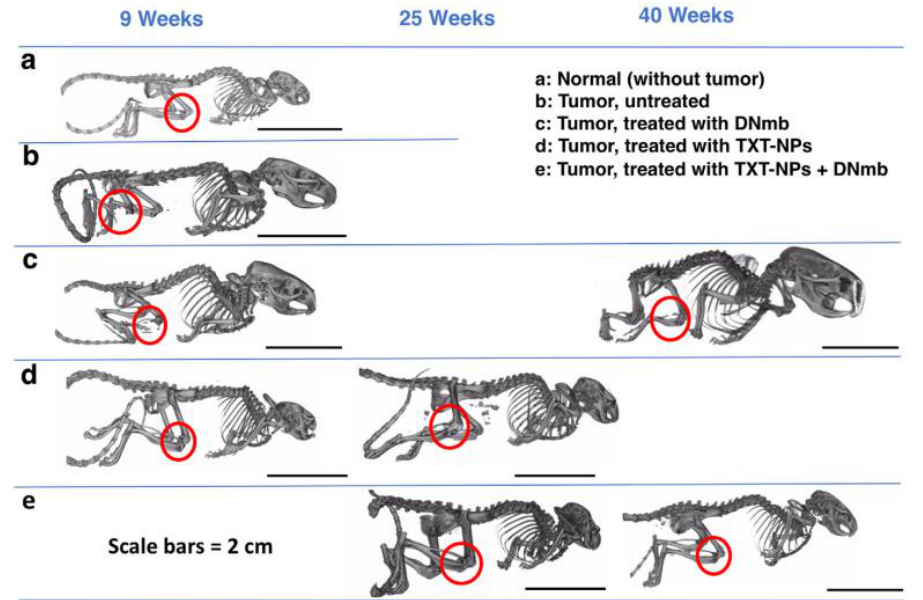
Figure 2. Micro-CT analysis for bone loss. Representative animals from different treatment groups underwent microCT at 9, 25, and 40 weeks. Group a : Normal (without tumor), b : Tumor, untreated, c : Tumor, treated with DNmb, d : Tumor, treated with TXT-NPs, e : Tumor, treated with TXT-NPs & DNmb. The combination treatment inhibited bone resorption most effectively. Histochemical analyses of the bone of the combination-treated animal demonstrated normal bone morphology, alkaline phosphate activity (a marker of osteoblasts), and tartrate-resistant acid phosphatase activity (a marker of osteoclasts). Reproduced with permission from [155].